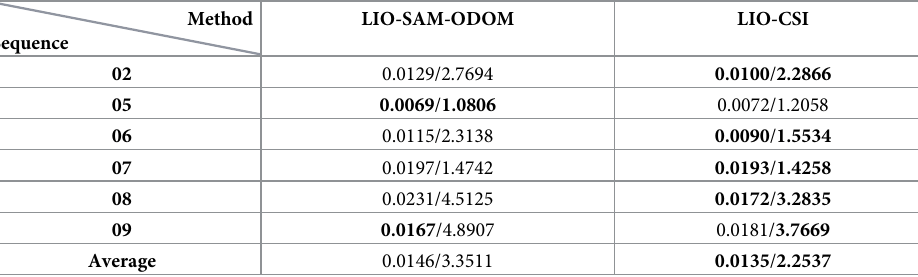
Table 5. Relative pose error of LIO-SAM-ODOM and